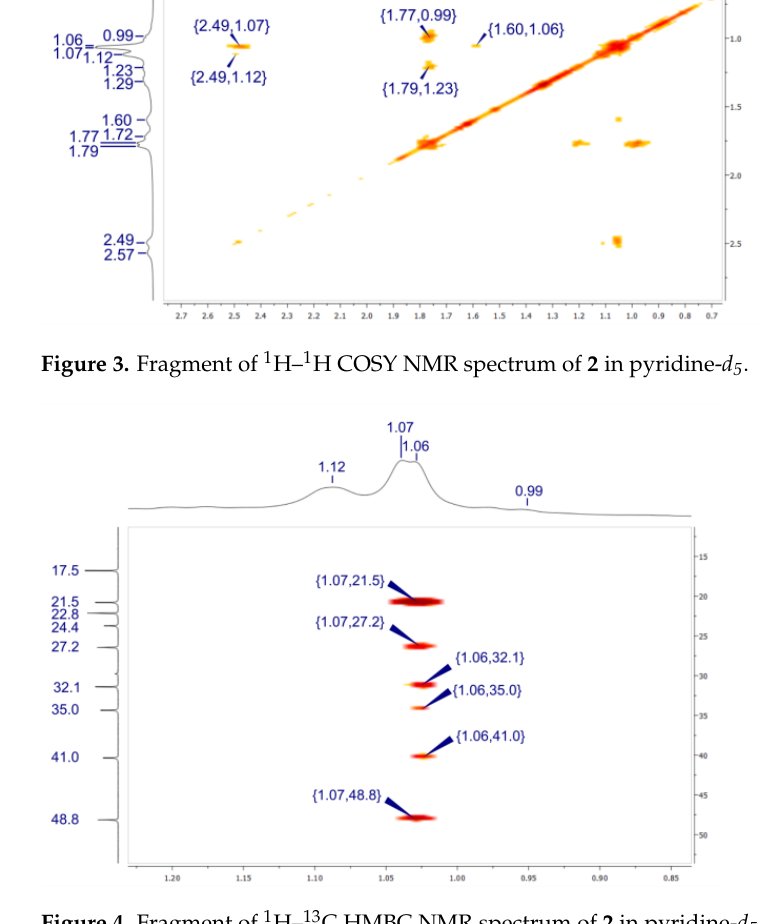
Figure 4. Fragment of 1 H– 13 C HMBC NMR spectrum of 2 in pyridine- d 5